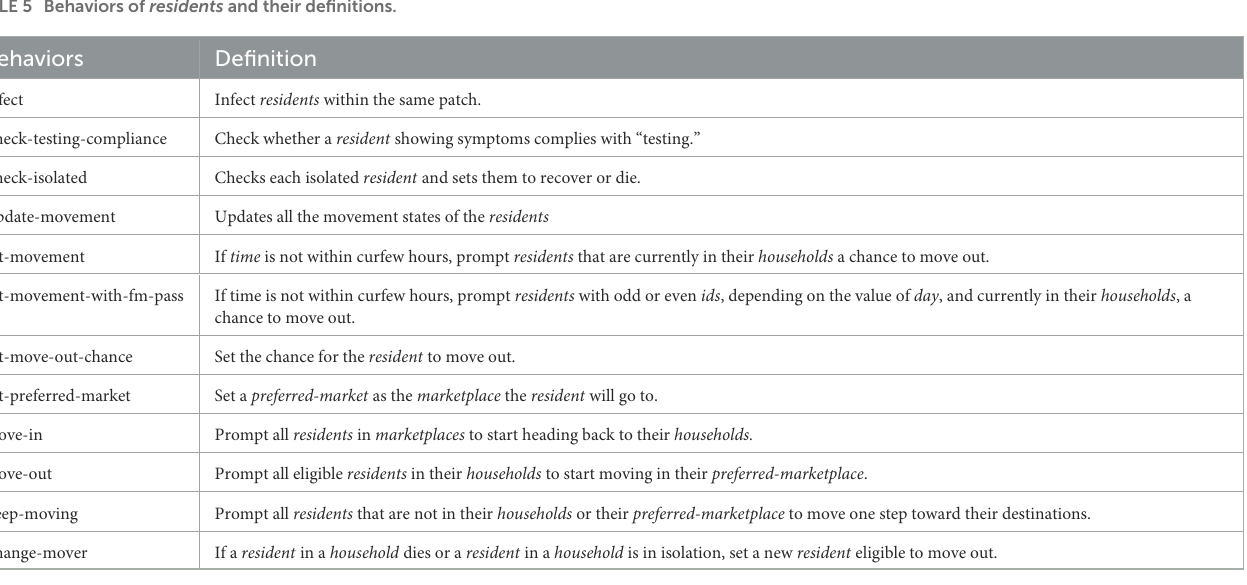
TABLE 5 Behaviors of residents and their